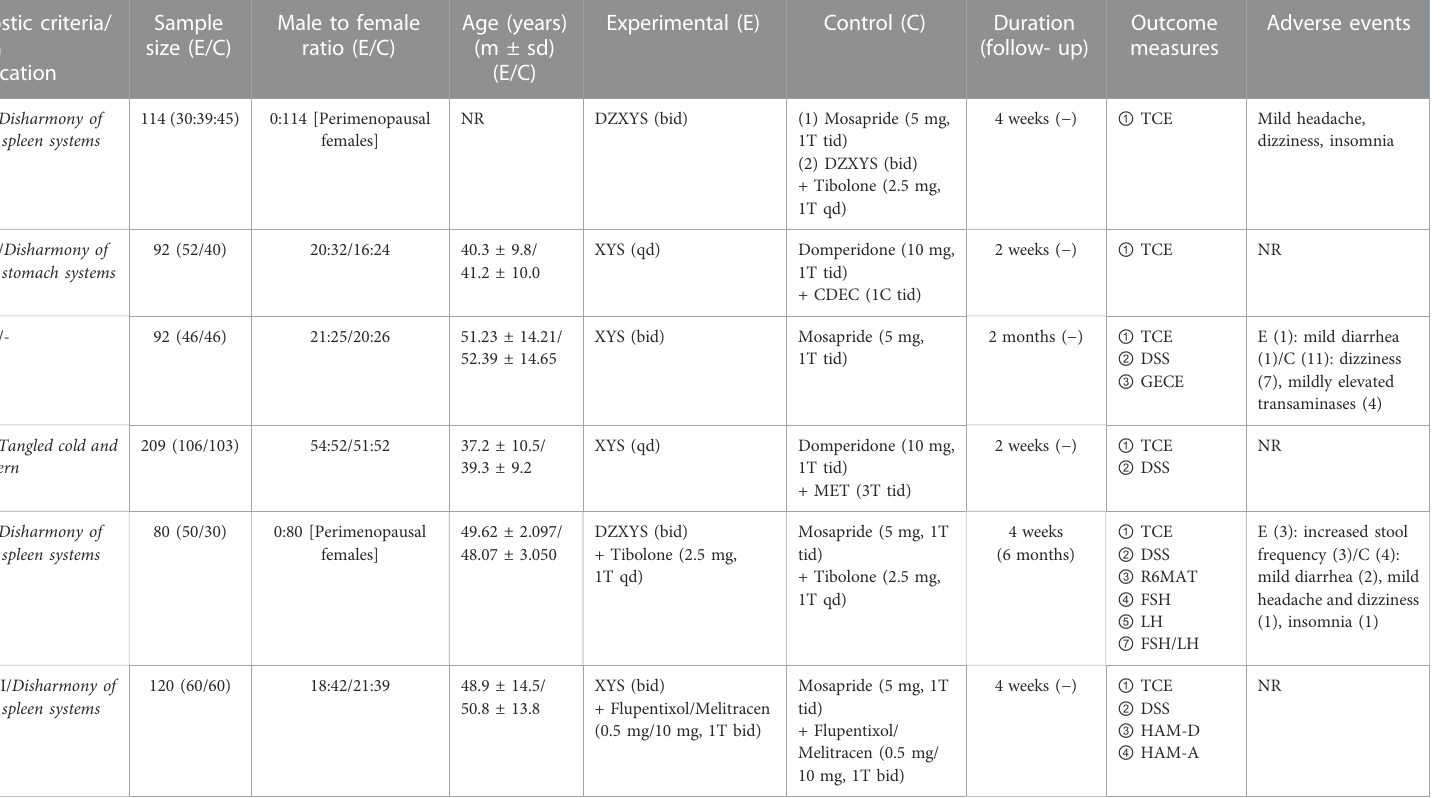
TABLE 2 Characteristics of included